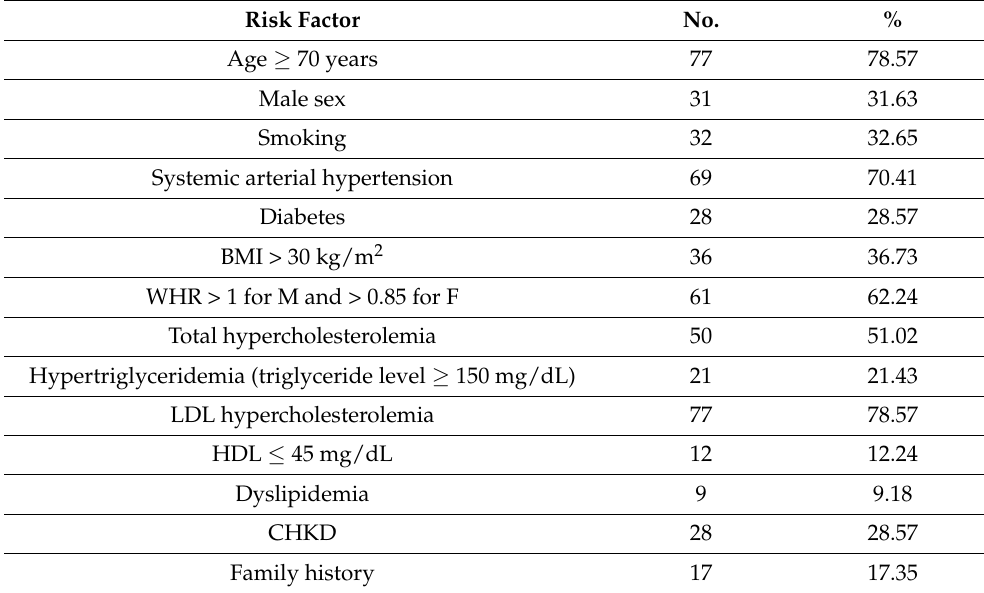
Table 1. Distribution of risk factors in the study